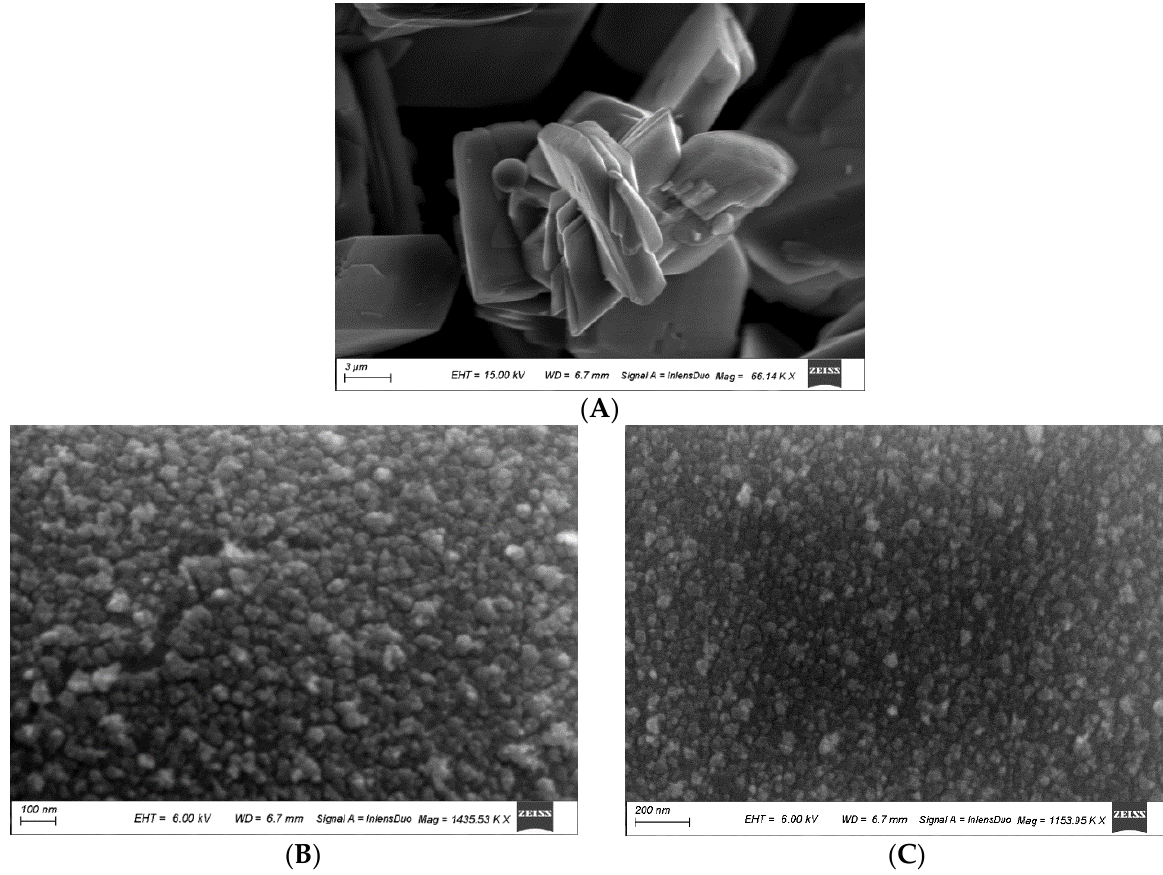
Figure 2. Scanning Electron Micrograph (SEM) of brushite phase ( A ), Scanning Electron Micrograph (SEM) of brushite phase at two different magnifications ( B , C ).